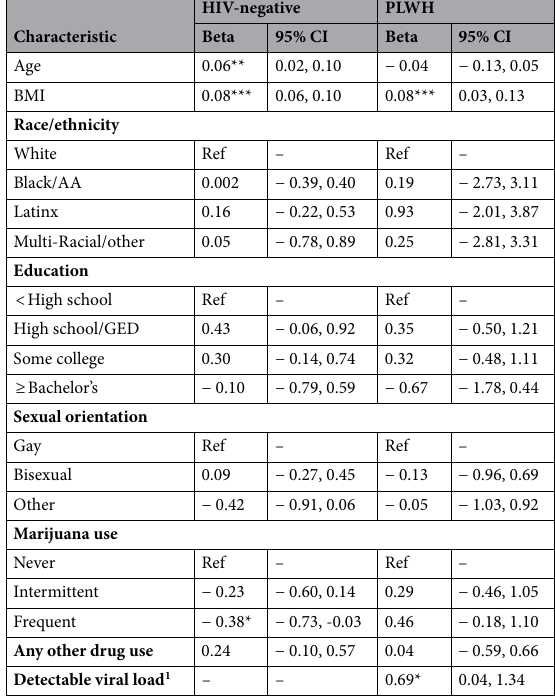
Table 4. Adjusted multivariable linear regression results examining the association between marijuana use and log CRP among HIV-negative participants and persons living with HIV (PLWH), RADAR,